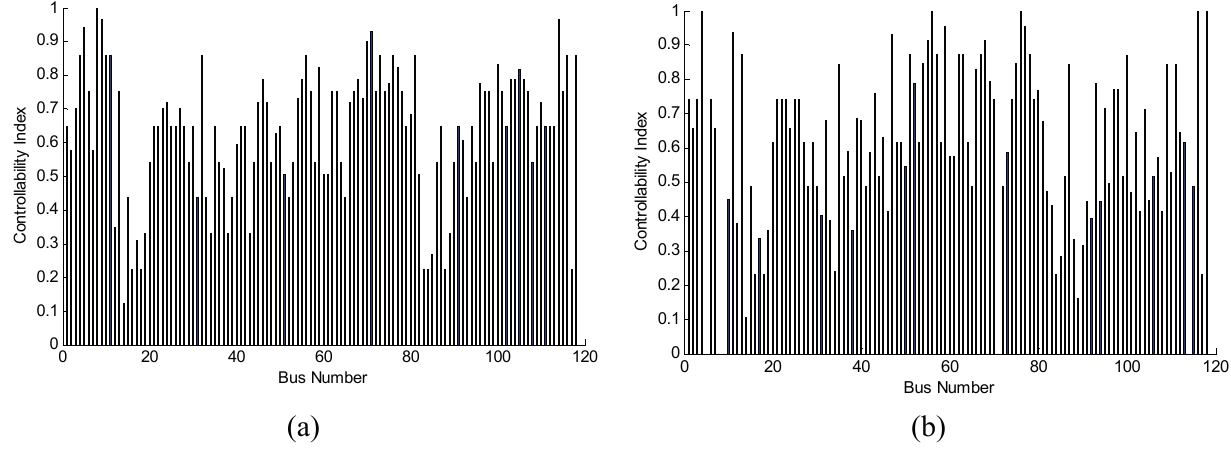
Figure 6. Effect of targeted attacks on controllability index distribution. ( a ) Original distribution; ( b ) Distribution after five targeted